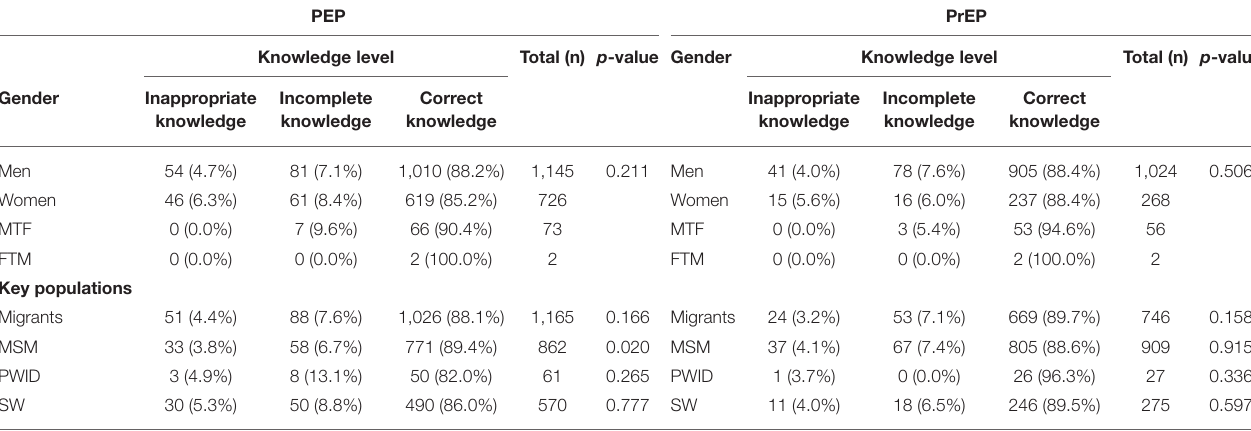
TABLE 3 | Knowledge levels of PEP and PrEP among the participants reporting to be aware of each tool, by gender and key